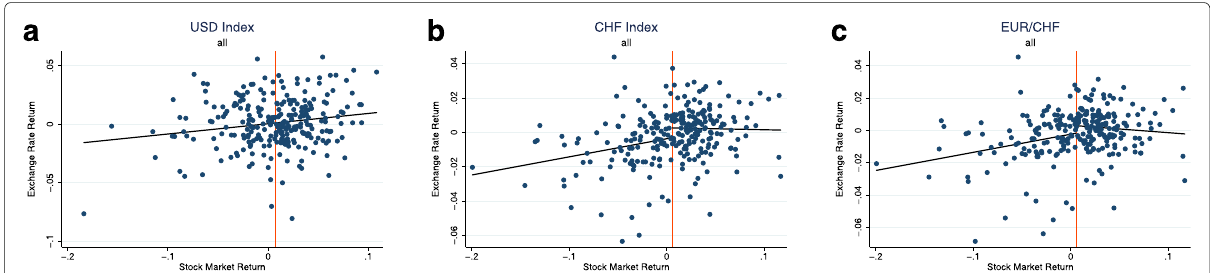
Fig. 1 ( a - c ) Scatterplots—full sample. Notes: These scatterplots show the relationship between monthly domestic stock market returns and exchange rate returns (end of period values) for the time period January 1990 to August 2011. Domestic stock market returns are calculated